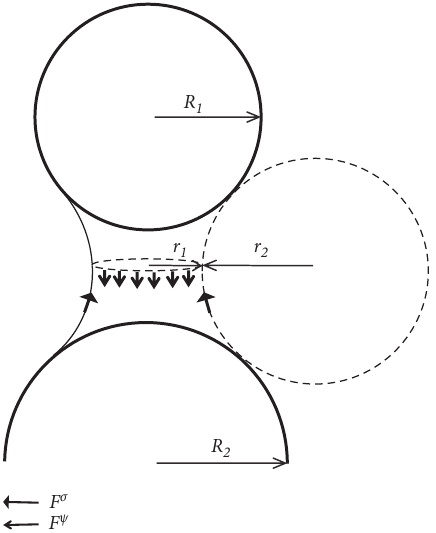
Figure 2: The force in the neck of a liquid bridge.